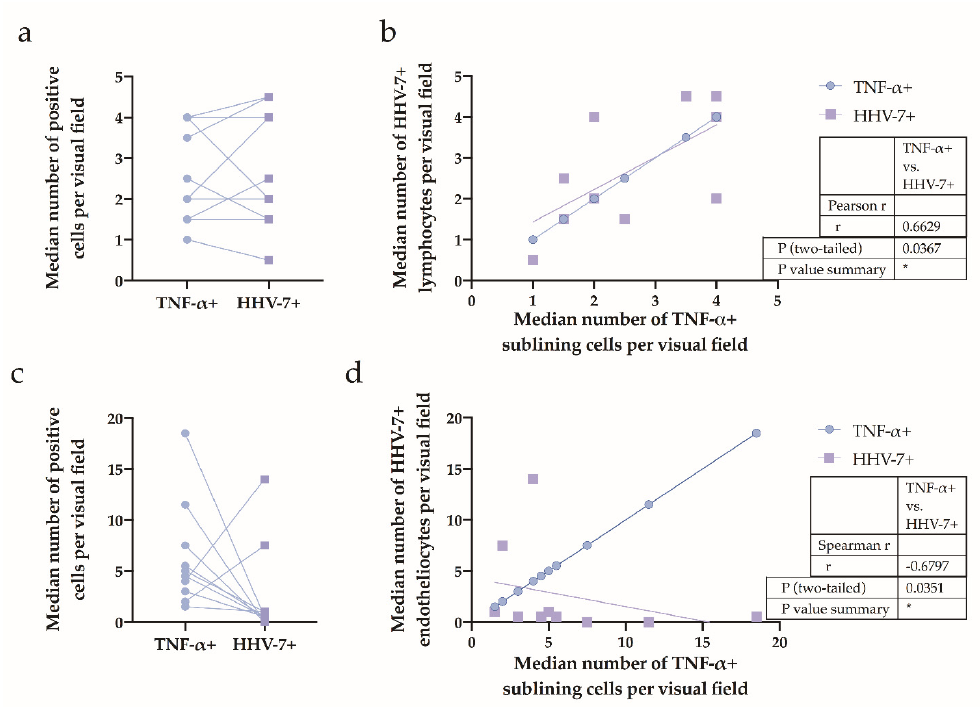
Figure 6. Assessment of synovial HHV-7-positive cells—lymphocytes (panel ( a ) and ( b )) and vascular endothelial cells (panel ( c ) and ( d )), and TNF-positive cells in the HHV-7 PCR + group. ( a ) Median numbers assessed for immunohistochemically confirmed positive cells are plotted for the TNF and HHV-7 antigen. Each dot represents a single data point; blue dots represent TNF+ cells, and violet squares represent HHV-7+ lymphocytes. ( b ) Correlation between the median number of TNF+ cells and HHV-7+ lymphocytes expressed per visual field and detected in the samples of the HHV-7 PCR+ group; r = 0.6629, p = 0.0367. Each dot represents a single data point; blue dots represent TNF+ cells, and violet squares represent HHV-7+ lymphocytes. Correlations determined by Pearson’s rank correlation test. ( c ) Median numbers assessed for immunohistochemically confirmed positive cells are plotted for the TNF and HHV-7 antigen. Each dot represents a single data point; blue dots represent TNF + cells, and violet squares represent HHV-7 + endotheliocytes. ( d ) Correlation between the median number of TNF + cells and HHV-7 + endotheliocytes expressed per visual field and detected in the samples of the HHV-7 PCR + group; r = − 0.6797, p = 0.0351. Each dot represents a single data point; blue dots represent TNF + cells, and violet squares represent HHV-7 + endotheliocytes. Correlations were determined by the Spearman’s rank correlation